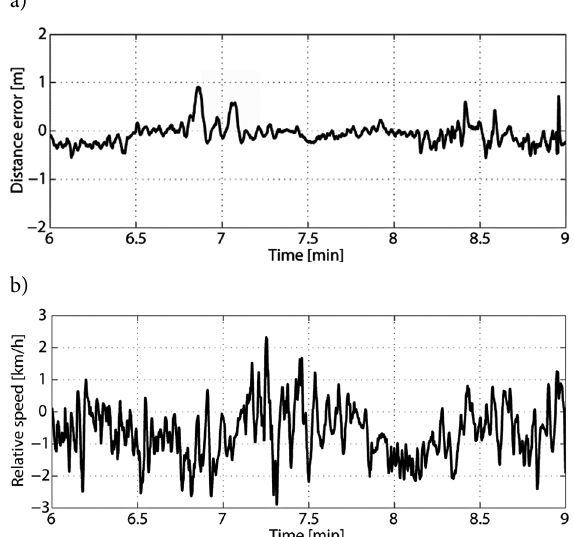
Fig. 12. Evolution of the input variables for longitudinal control: a – distance error; b – relative speed